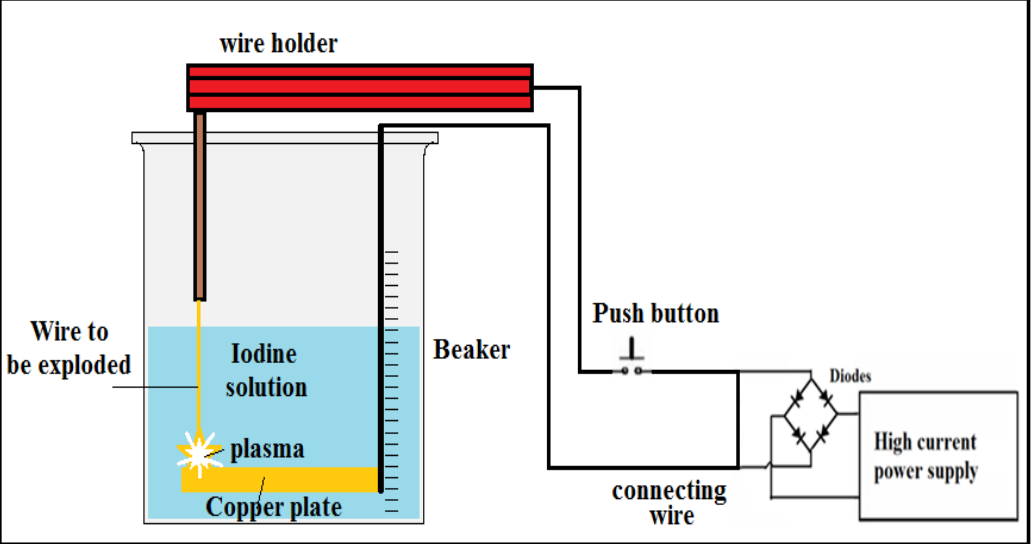
Fig. 1: Schematic for exploding